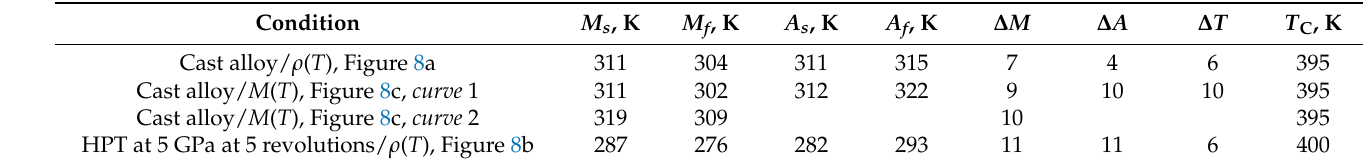
Table 2. Critical temperatures of the TMP-transformed alloy Ni 50 Mn 28.5 Ga 21.5